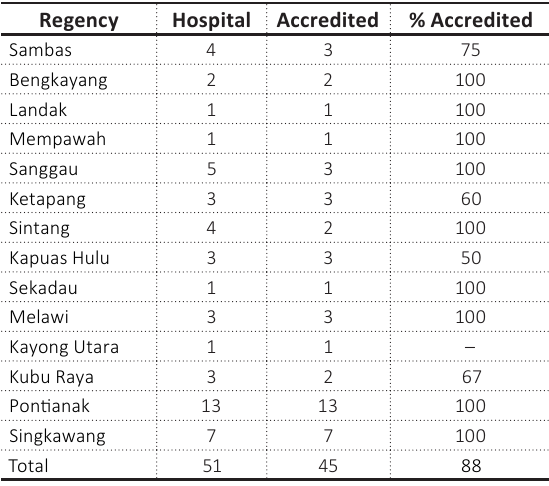
Table 1. Accredited hospitals by regency in West